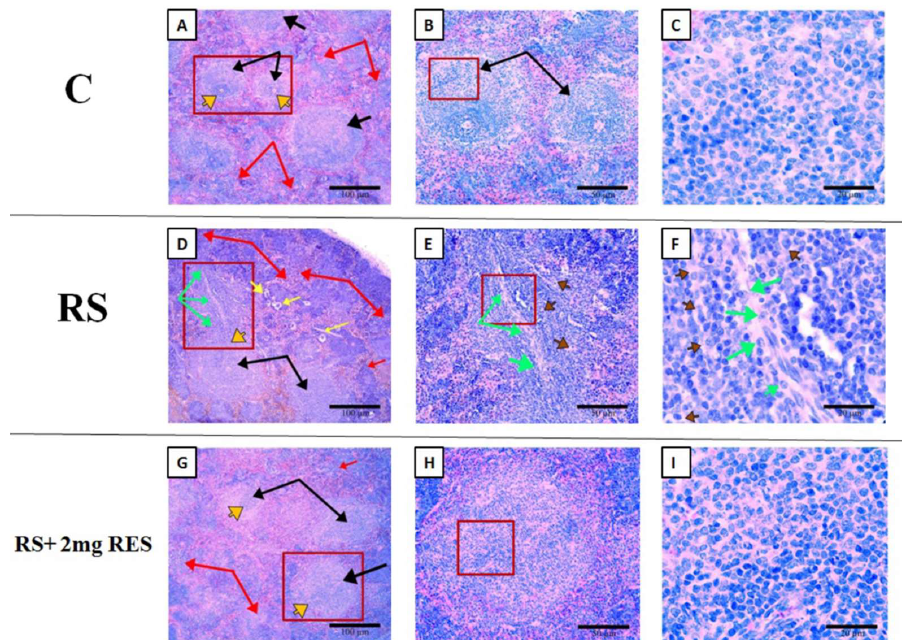
Figure 9. Histopathologic analysis of H&E staining of the splenic structures of non-stressed control mice (C), restraint-stressed mice (RS), and restraint-stressed mice treated with 2 mg / kg body weight of resveratrol (RS + 2 mg RES). Scale bar is 100 µ m ( A , D , G ), 50 µ m ( B , E , H ), and 20 µ m ( C , F , I ). ( A , D , G ) Black arrows point to the white pulp. ( A , D , G ) Red arrows point to the red pulp. There is disruption of the normal splenic architecture by a di ff use infiltrate predominantly expanding the white pulp ( D , green arrows), loss of typical structure of the germinal center ( G , C ) ( D , orange arrows), proliferation of large atypical lymphoid cells with bizarre nuclei ( E and F , brown arrows), and prominent eosinophilic nucleoli surrounded by abundant cytoplasm ( E and F , green arrows). The red pulp was also enlarged and increased ( D , red arrows), containing extramedullary hematopoiesis and prominent megakaryocytes ( D , yellow arrows) in the RS group relative to the controls ( A – C ) and RS + 2 mg RES ( G – I ) groups, which show normal histology in the white and red pulp of the spleen.